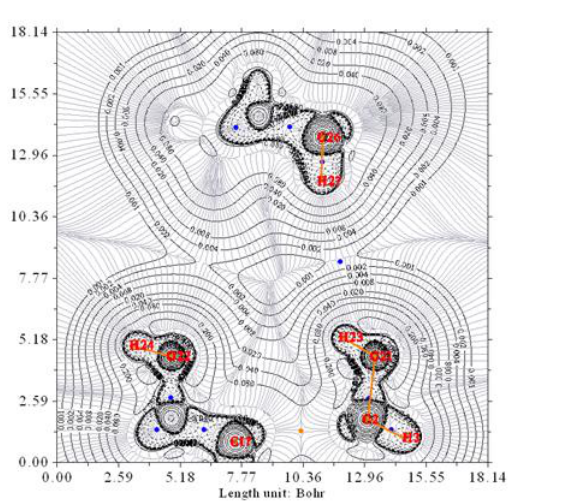
Figure 8. The electron density contour of the O 12a -H/H ... O 7a //O 12b -H/H ... O 7b complex (thin black lines). O 7a and O 7b are oxygen atoms from the pseudo-bile acid residues. Thin gray lines correspond to the gradient of the electron density.